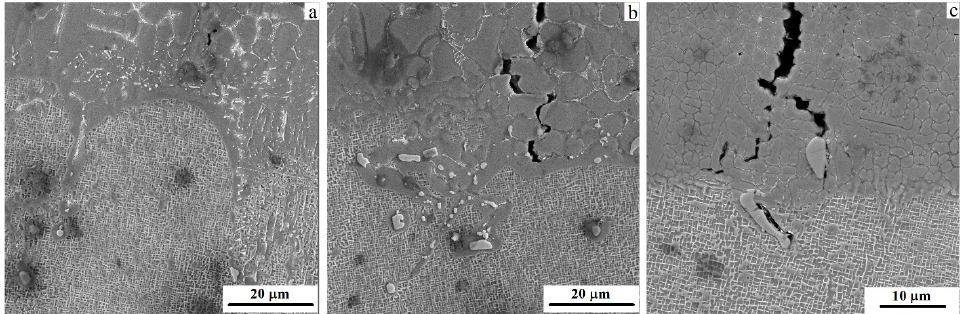
Figure 4. SEM images of microstructure in samples after laser melting: ( a , b ) melting deep into the grain boundary; ( c ) samples with cracks near carbide particles.